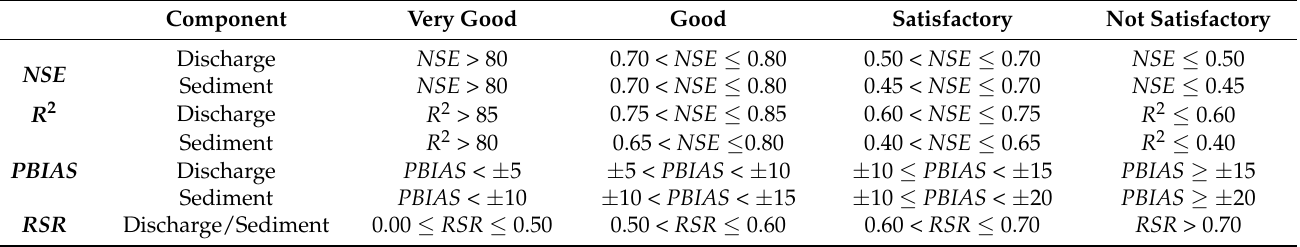
Table A3. Statistics recommended by Moriasi et al. [59,65] to evaluate the performance of the SWAT